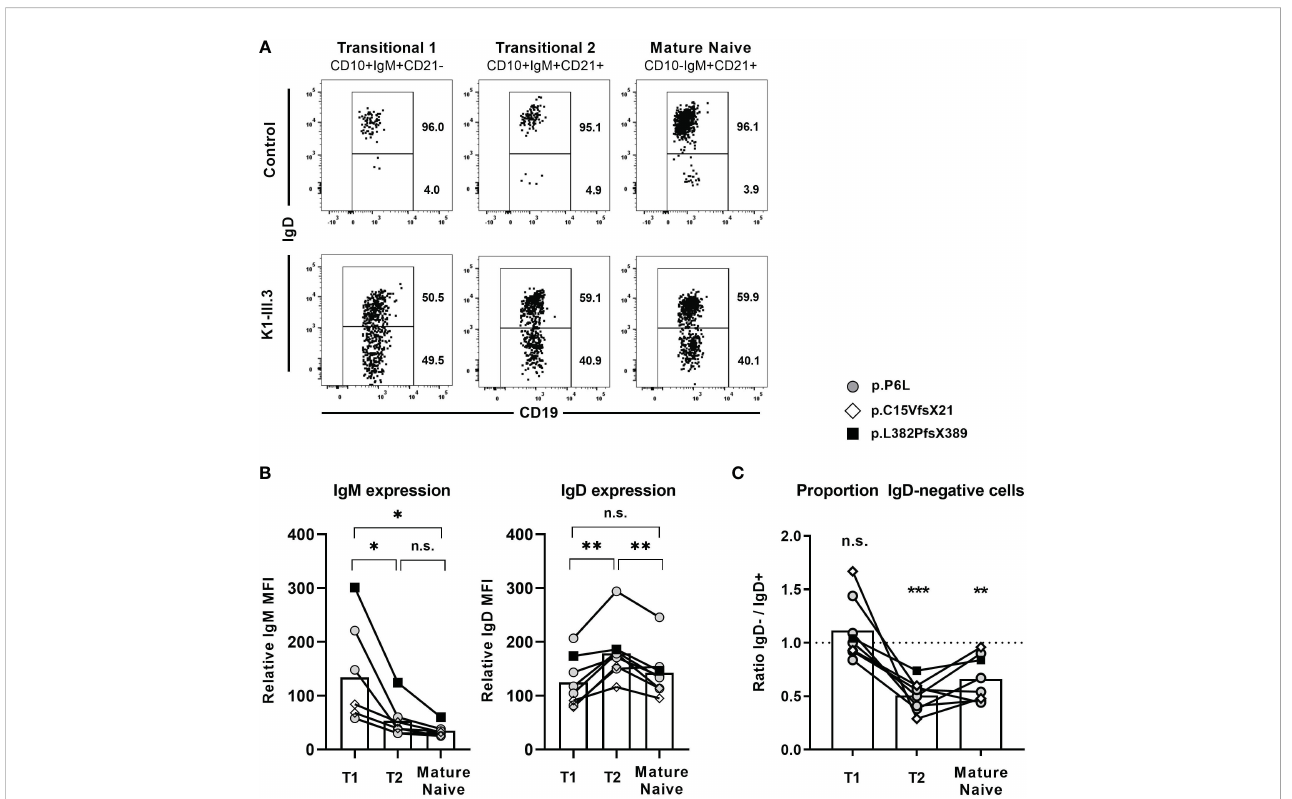
FIGURE 6 IgD-positive B cells outcompete IgD-negative B cells within the naïve B cell compartment (A) Representative dot blot obtained from fl ow cytometric analysis of CD19 + peripheral blood B cells from a control individual and an individual carrying a heterozygous IGHD variant showing the distribution of IgD + and IgD - cells within CD27 - IgM + CD10 + CD21 - transitional 1 B cells, CD27 - IgM + CD10 + CD21 + transitional 2 B cells and CD27 - IgM + CD10 - CD21 + mature naive B cells. (B) Compiled fl ow cytometric data of IgM and IgD surface expression levels in IgD + transitional 1 (T1), transitional 2 (T2) and mature naïve IgD+ B cells in 8 individuals carrying different IGHD variants. The relative mean fl uorescence intensity (MFI) was calculated as IgD or IgM MFI on different B cell subsets divided through the MFI on CD19 - non-B cells (background). (C) The distribution of IgD- B cells within each B cell subset was analyzed as ratio IgD-/IgD + cells. (*, p < 0.05; **, p < 0.01; ***, p < 0.001; n.s., not signi fi cant; (B) One-Way-ANOVA with Turkey`s multiple comparison test; (C) one sample t-test with hypothesized mean of